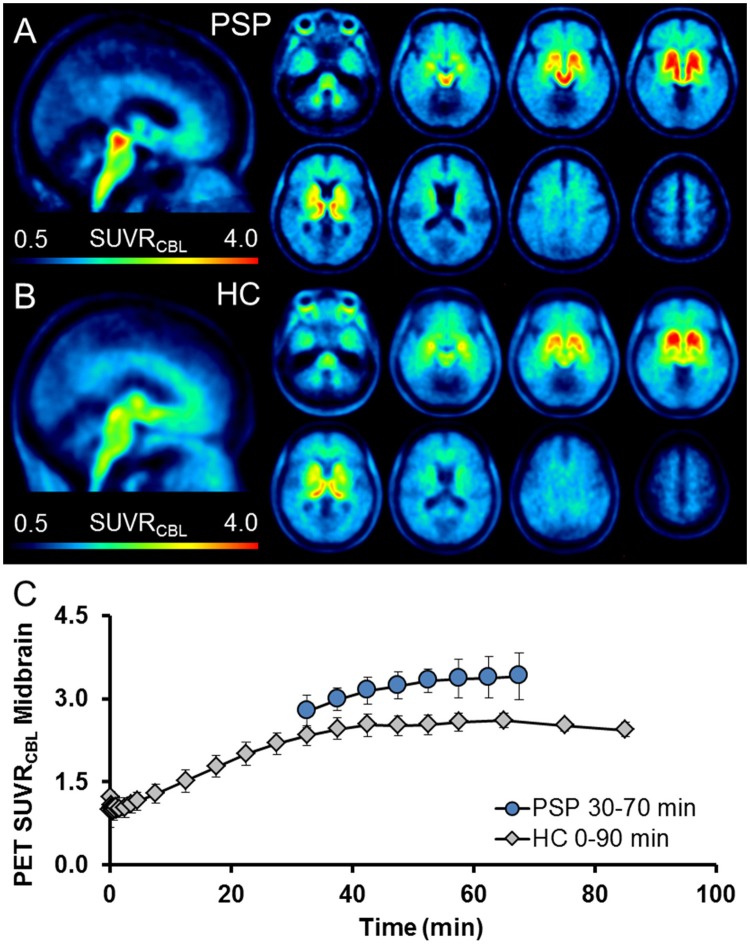
High midbrain uptake in sagittal slices allows visual discrimination of the PSP patient group (A) from the healthy control group (HC) (B). Axial slices through the brain indicate high background binding in the basal ganglia and brainstem regions of HC, but further elevation in regions with known tau deposition in PSP vs. HC (midbrain, dentate nucleus, globus pallidus, frontal cortex). Images represent group averages. (C) Dynamic imaging indicates stable kinetics ≥ 50 min p.i. as illustrated by a persistently higher time-activity-curve (ratio), deriving from PSP patients in contrast to the mean for the healthy control group (mean ± SD). Data points represent an average of all counts in a defined time frame.